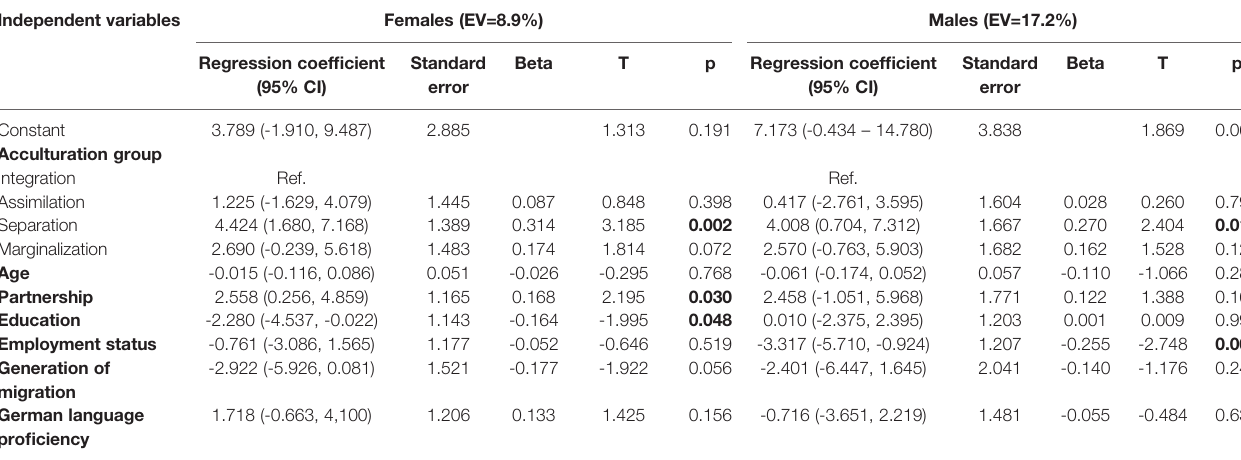
TABLE 4 | Multiple linear regression analyses of depressive symptoms (PHQ-9) for female and male migrants of Turkish origin. Independent variables Females (EV=8.9%)